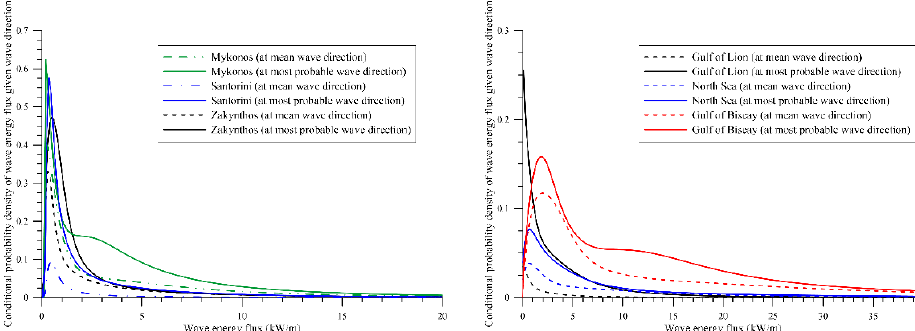
Figure 7. Distribution of wave energy flux for the mean and the most probable wave direction at the examined locations. Left panel: Mykonos, Santorini, and Zakynthos. Right panel: Gulfs of Lion and Biscay and North Sea.